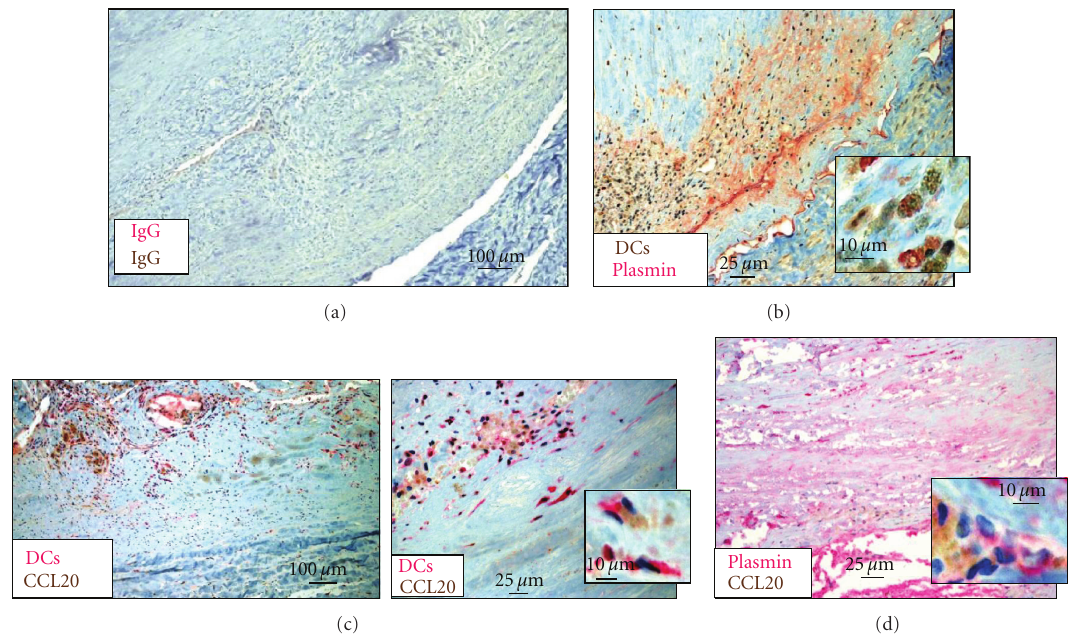
Figure 1: CCL20 is present in human atherosclerotic lesions, where it colocalizes with plasmin and dendritic cells. (a) Negative control. Sections of human atherosclerotic abdominal aorta specimens were stained with control antibodies and visualized with double immunostaining using AP- and HRP-conjugated secondary antibodies and FastRed (pink) and DAB (brown) substrates. Original magnification is × 100. (b) Plasmin colocalizes with dendritic cells. Sections of human atherosclerotic abdominal aorta specimens were stained with antibodies against plasmin (AEC, red) and dendritic cell marker S100 (DAB, brown). Original magnifications × 200 and × 400. (c) CCL20 colocalizes with dendritic cells. Sections of human atherosclerotic abdominal aorta specimens were stained with antibodies against CCL20 (DAB, brown) and dendritic cell marker S100 (FastRed, pink). Original magnifications are × 100, × 200, and × 400. (d) Plasmin colocalizes with CCL20. Sections of human atherosclerotic abdominal aorta specimens were stained with antibodies against plasmin (FastRed, pink) and CCL20 (DAB, brown). Original magnifications are × 200 and ×